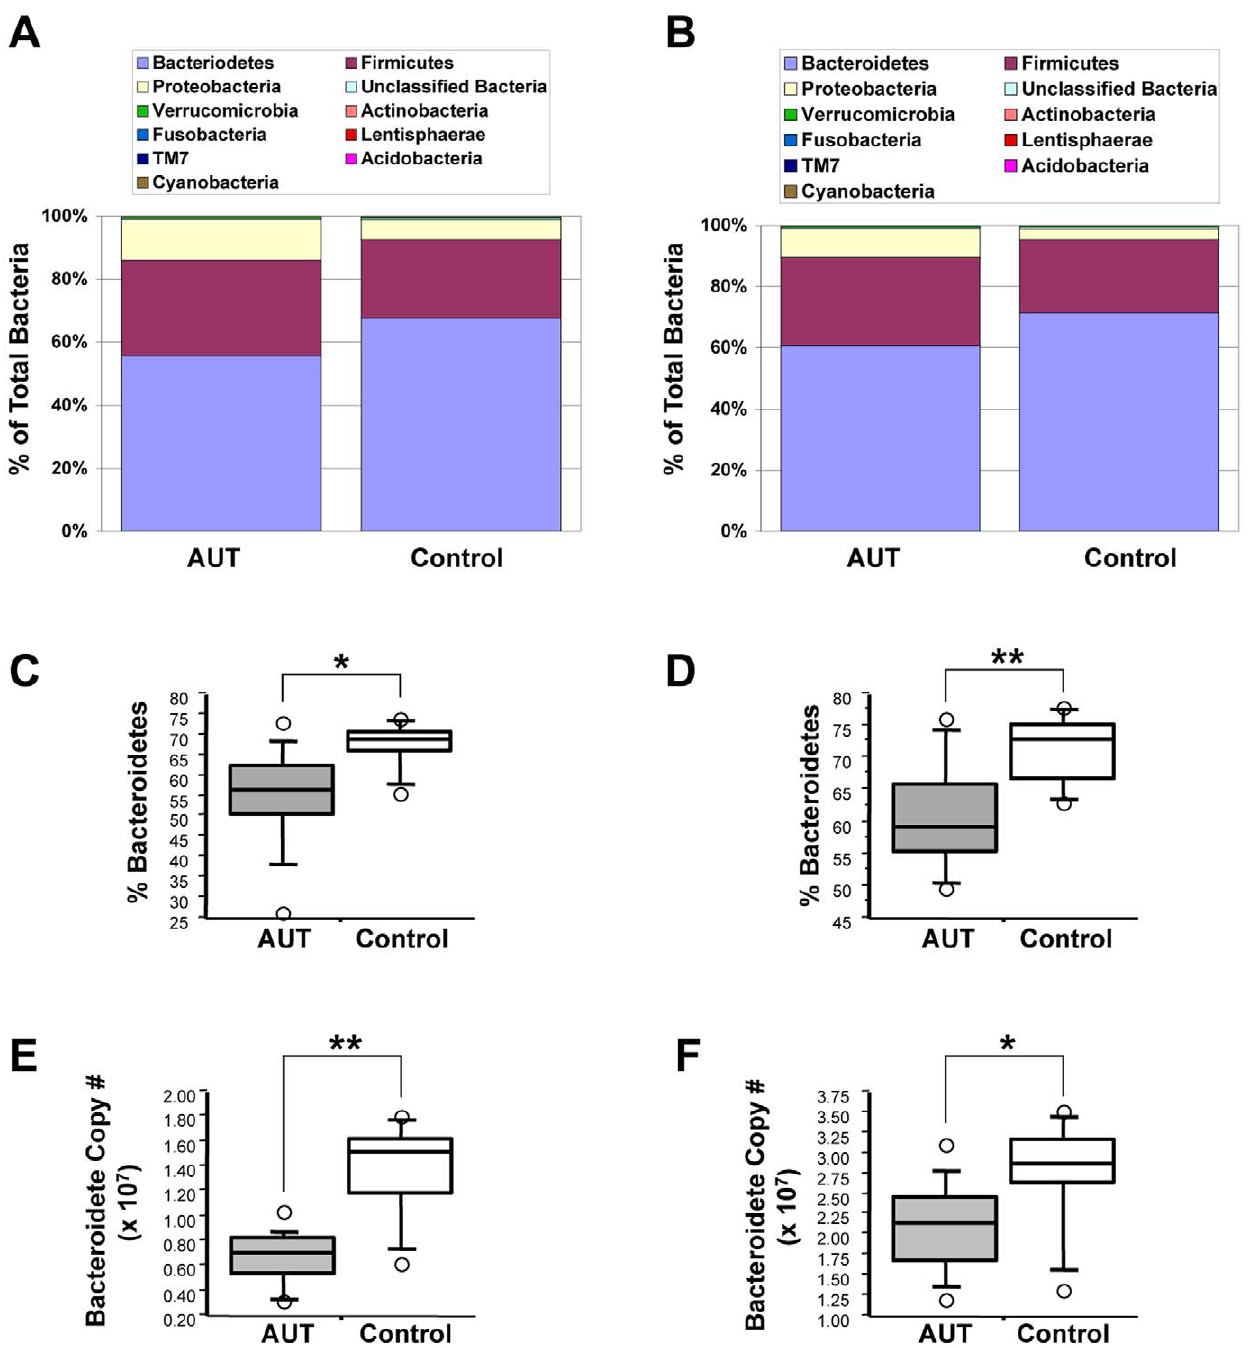
Figure 3. Composition of intestinal microflora in AUT-GI children. ( A–B ) Phylum-level comparison of the average relative abundance of bacterial taxa in ileal ( A ) and cecal ( B ) biopsies. ( C–D ) Bacteroidete abundance, obtained from pyrosequencing for ileal ( C ; Mann-Whitney, p =0.012) and cecal ( D ; Mann-Whitney, p =0.008) biopsies. ( E–F ) Bacteroidete-specific quantitative real-time PCR analysis of ileal ( E ; Mann-Whitney, p =0.003) and cecal ( F ; Mann-Whitney, p =0.022) biopsies; copy number values are normalized relative to total bacteria copy numbers. *, p , 0.05; **, p , 0.01.